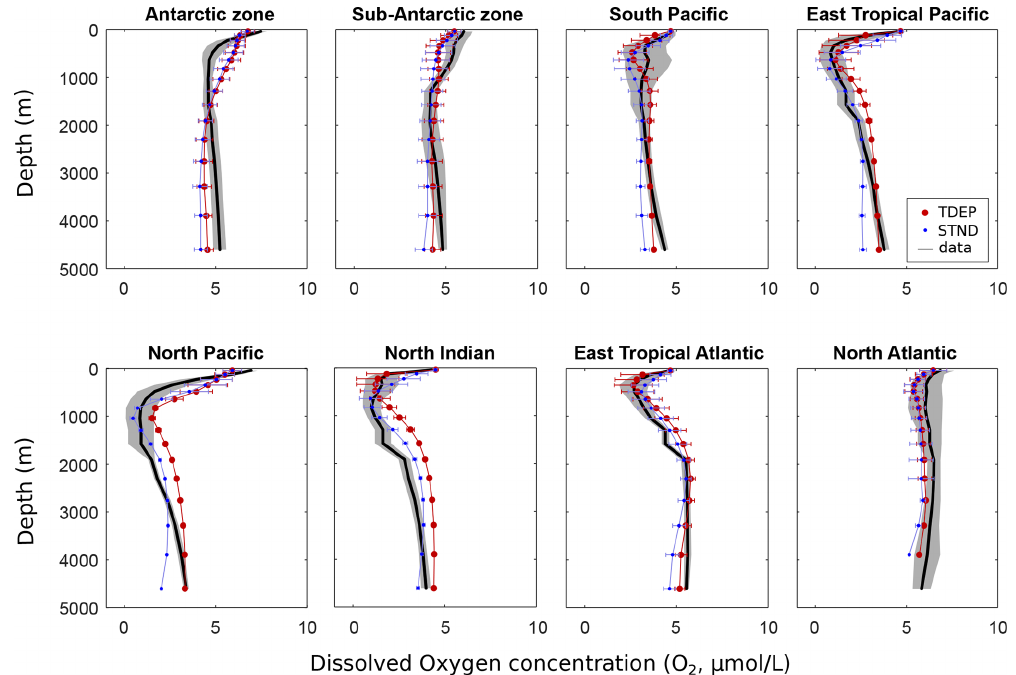
Figure 9. Dissolved O 2 (µmolL − 1 ) per depth by region for the model and data (mean and standard deviation). Data from WOA 2009 (Levitus et al., 2010). STND is the standard model, and TDEP is the temperature-dependent